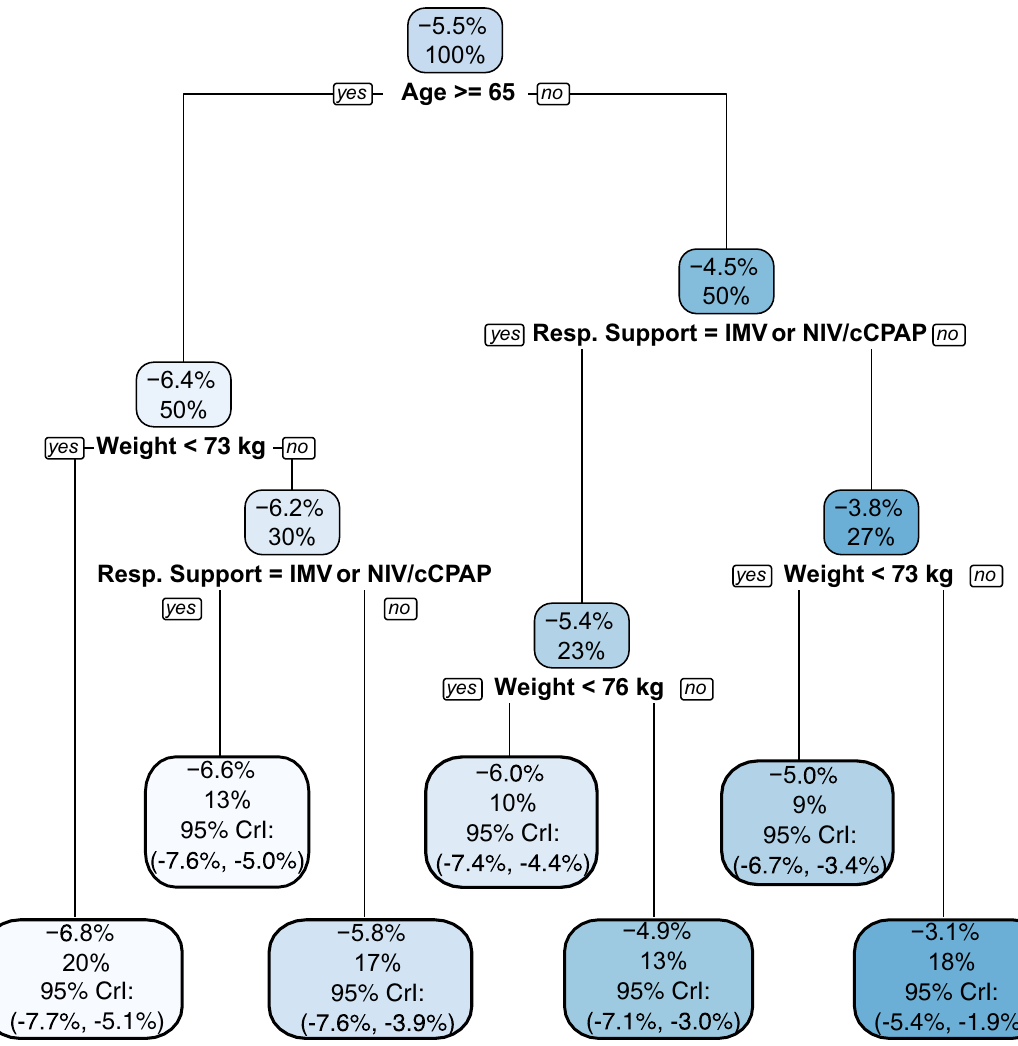
Figure 4. Model results for the binary outcome mortality at day 90. The top value in each box is the estimated treatment effect in the subgroup with corresponding covariate values (risk difference for 12 mg/d vs. 6 mg/d). The bottom value in each box is the proportion of the trial sample belonging to the subgroup. A complete walk through of the figure is provided in the main text (see results). The first square at the top indicates that the overall estimated risk difference in the trial was 5.5% in favor of 12 mg. Next, for those aged 65 years or older (50% of the sample), the estimated risk difference was 6.4%, while for those under age 65 (50% of the sample) the estimated risk difference was 4.5%, both in favor of 12 mg/d. Subsequent splits in the decision tree can be interpreted similarly. Cross validation selected a power prior of 3, a base prior of 0.25, and 400